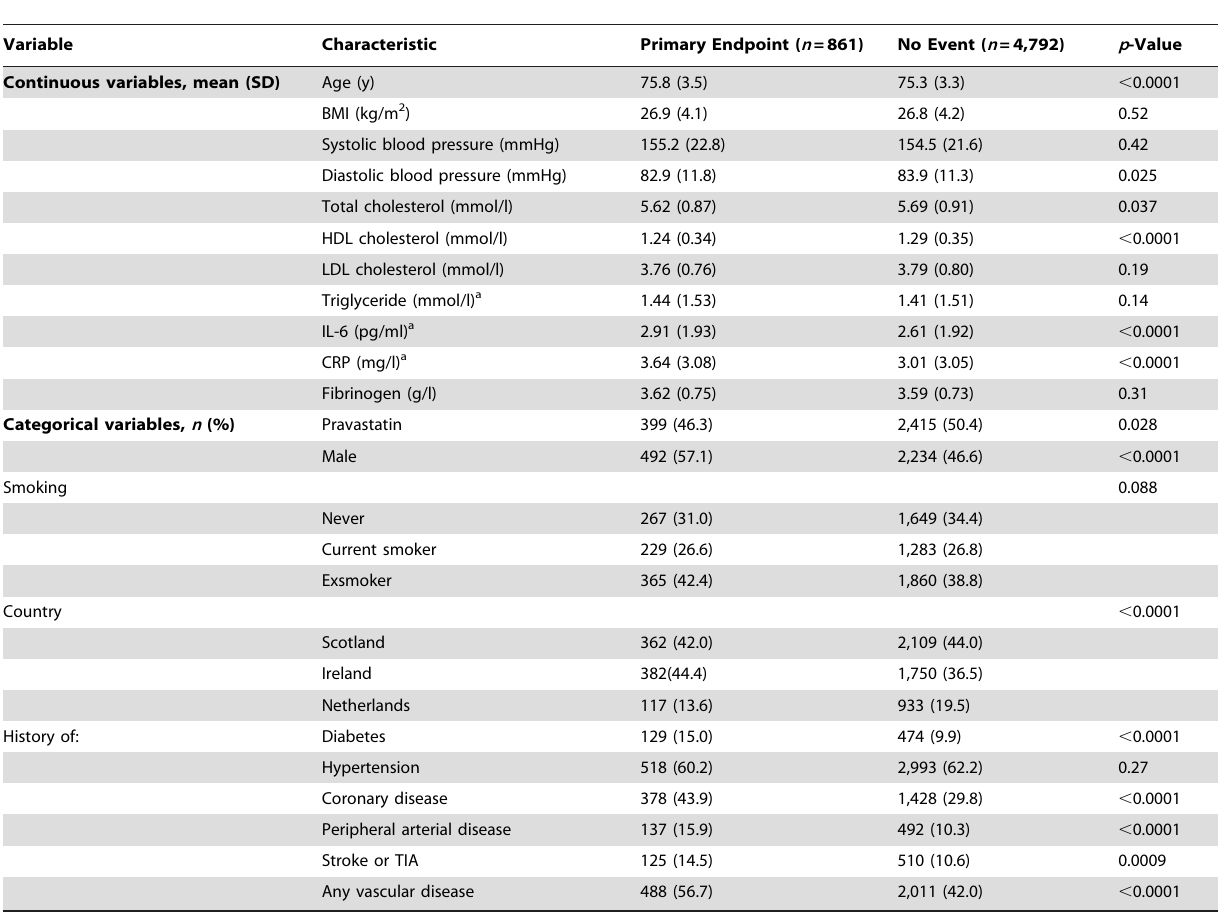
Table 1. Baseline characteristics by incident primary combined nonfatal and fatal endpoint ( p -value versus no event group).